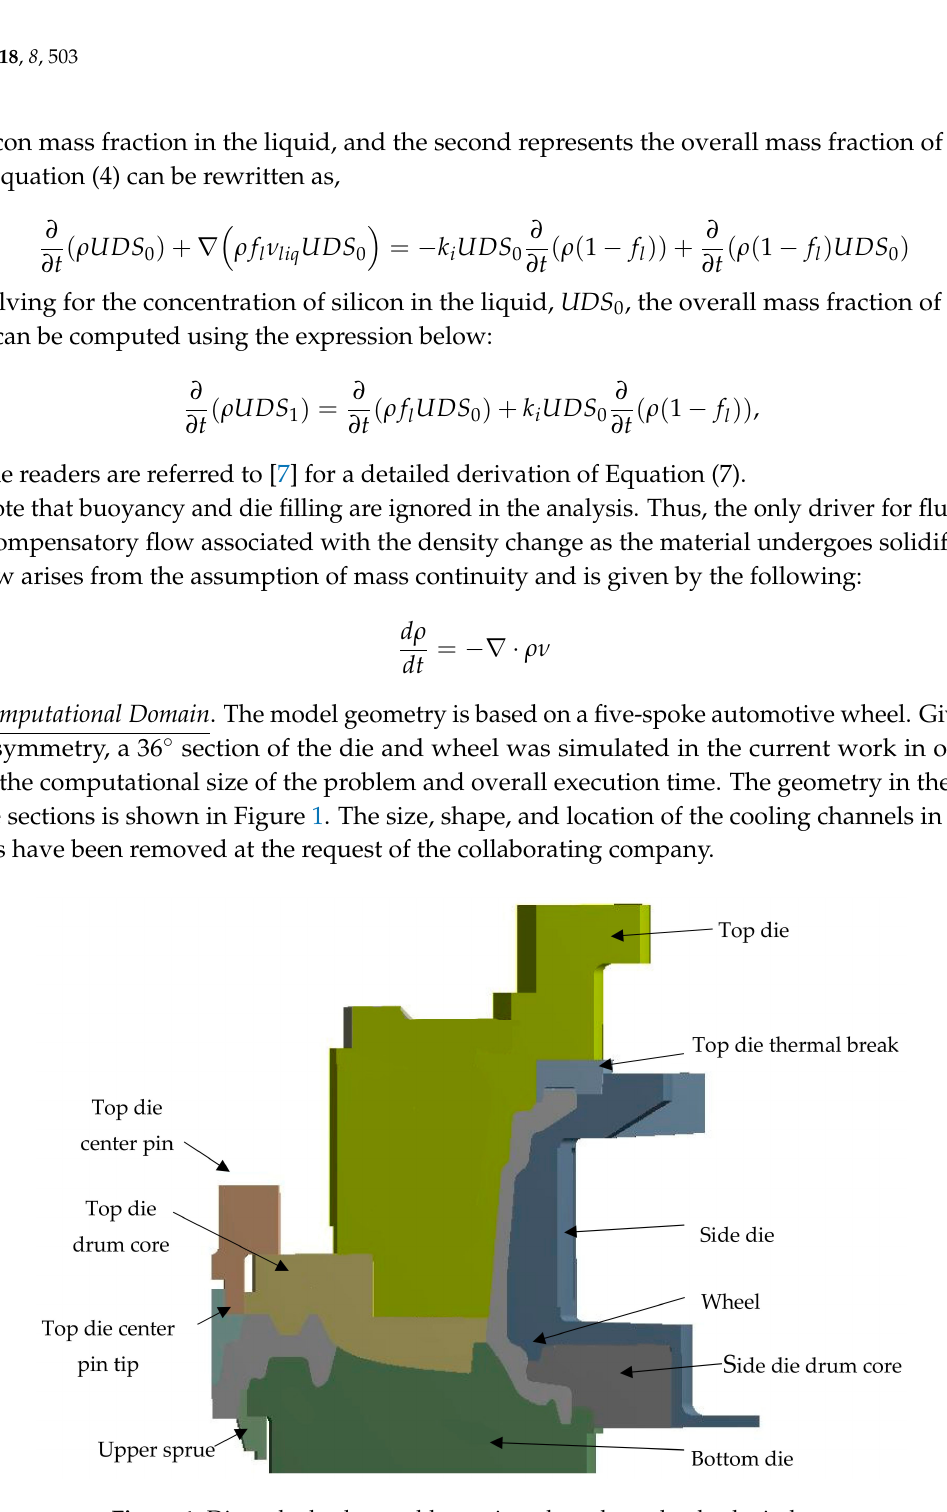
Figure 1. Die and wheel assembly, cutting plane through wheel